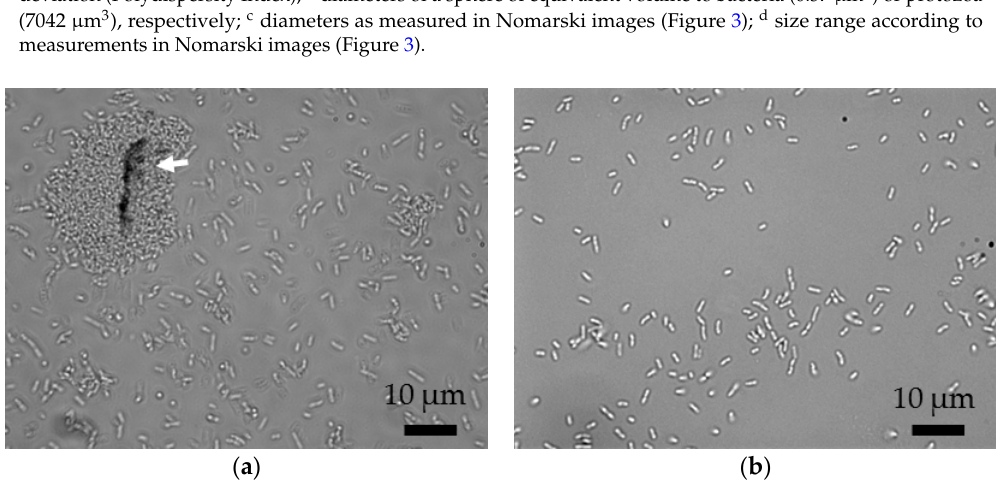
Figure 1. Representative phase contrast images of P. aeruginosa incubated with 5 mg/L MWCNTs